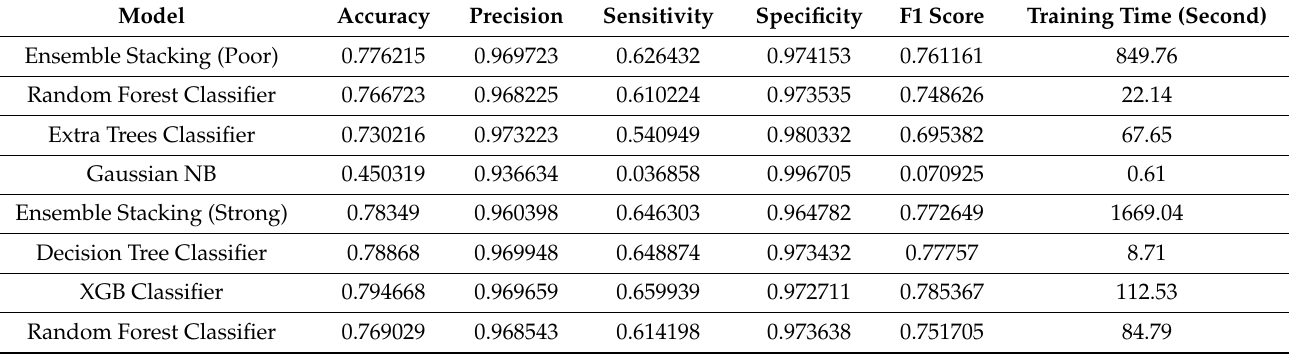
Table 6. Cyberattack detection using ensemble stacking for the NSL_KDD